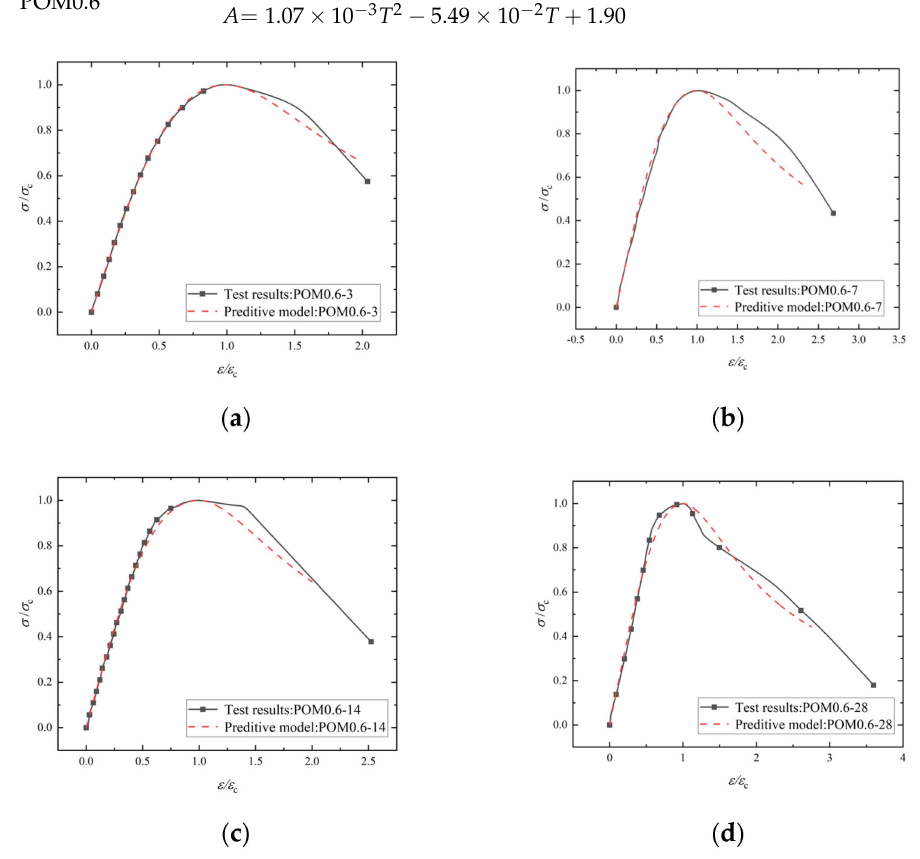
Figure 26. Fitting results of stress–strain curve of POM SWSSC: ( a ) POM0.6-3; ( b ) POM0.6-7; ( c ) POM0.6-14; and ( d )